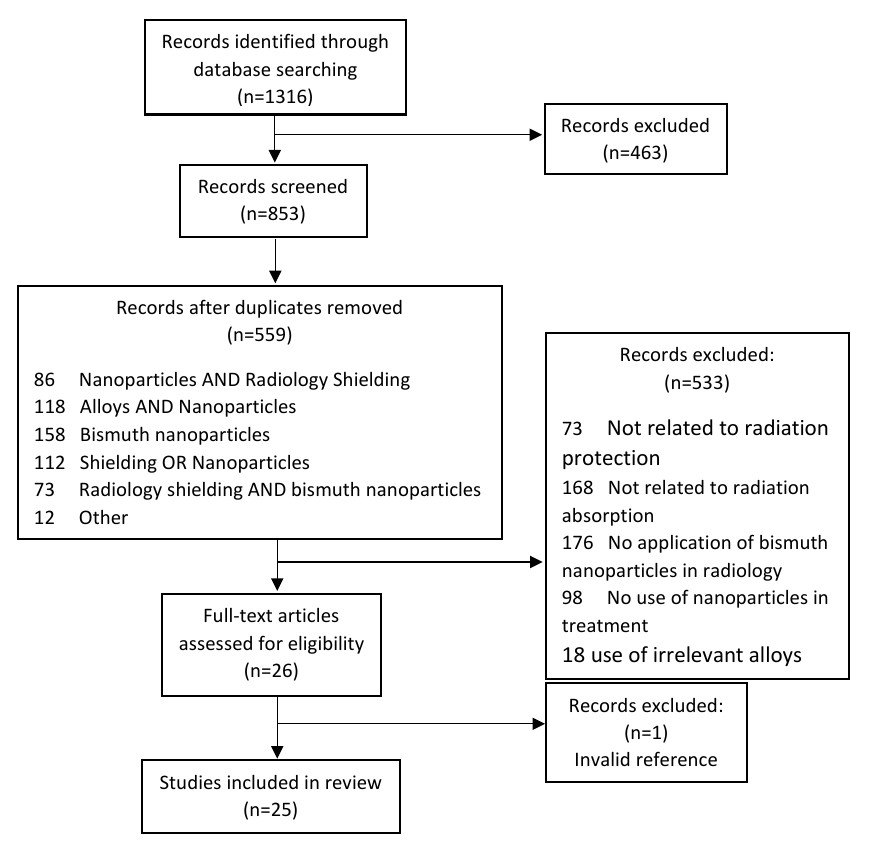
Figure 1 : Flowchart of article selection Figure 1. Flowchart of Article Selection Process.